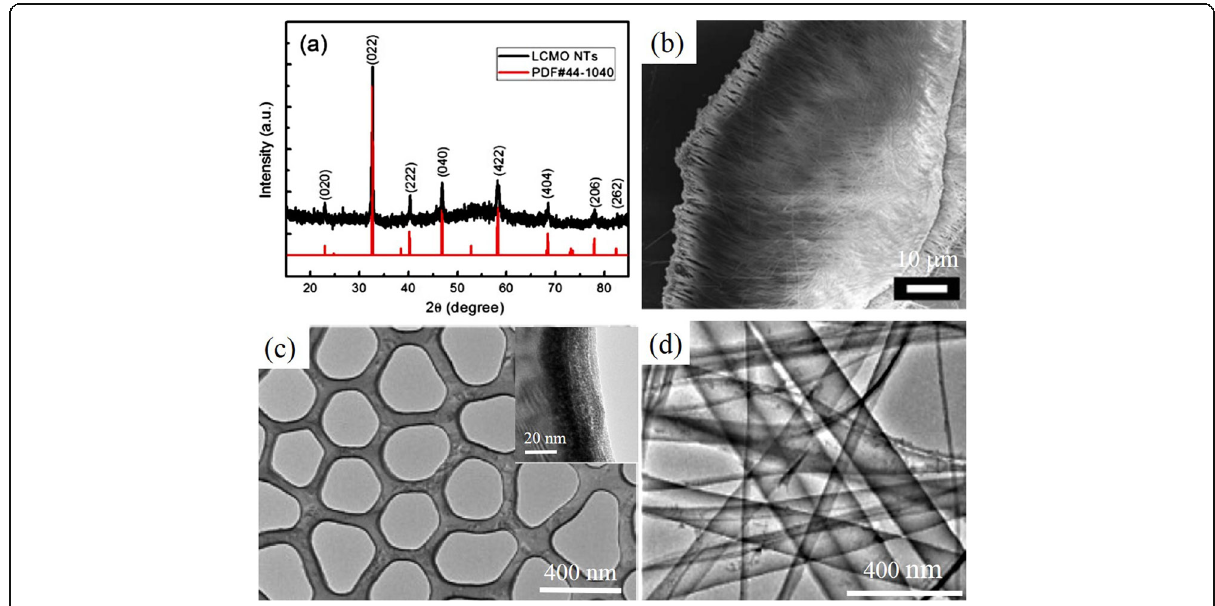
Fig. 10 a XRD pattern of La 0.75 Ca 0.25 MnO 3 (LCMO) nanotubes (NTs) prepared by template-assisted PLD method and its corresponding peak positions and intensity in JCPDS card no. 44-1040 of La 0.8 Ca 0.2 MnO 3 . b SEM image of the as-prepared LCMO nanotubes, and c cross-sectional TEM image of the LCMO nanotubes. d TEM images of the as-prepared LCMO nanotubes. Inset in ( c ) is enlarged local TEM image of nanotube, revealing the maximum observed wall thickness of about 20 nm. Reproduced with permission of